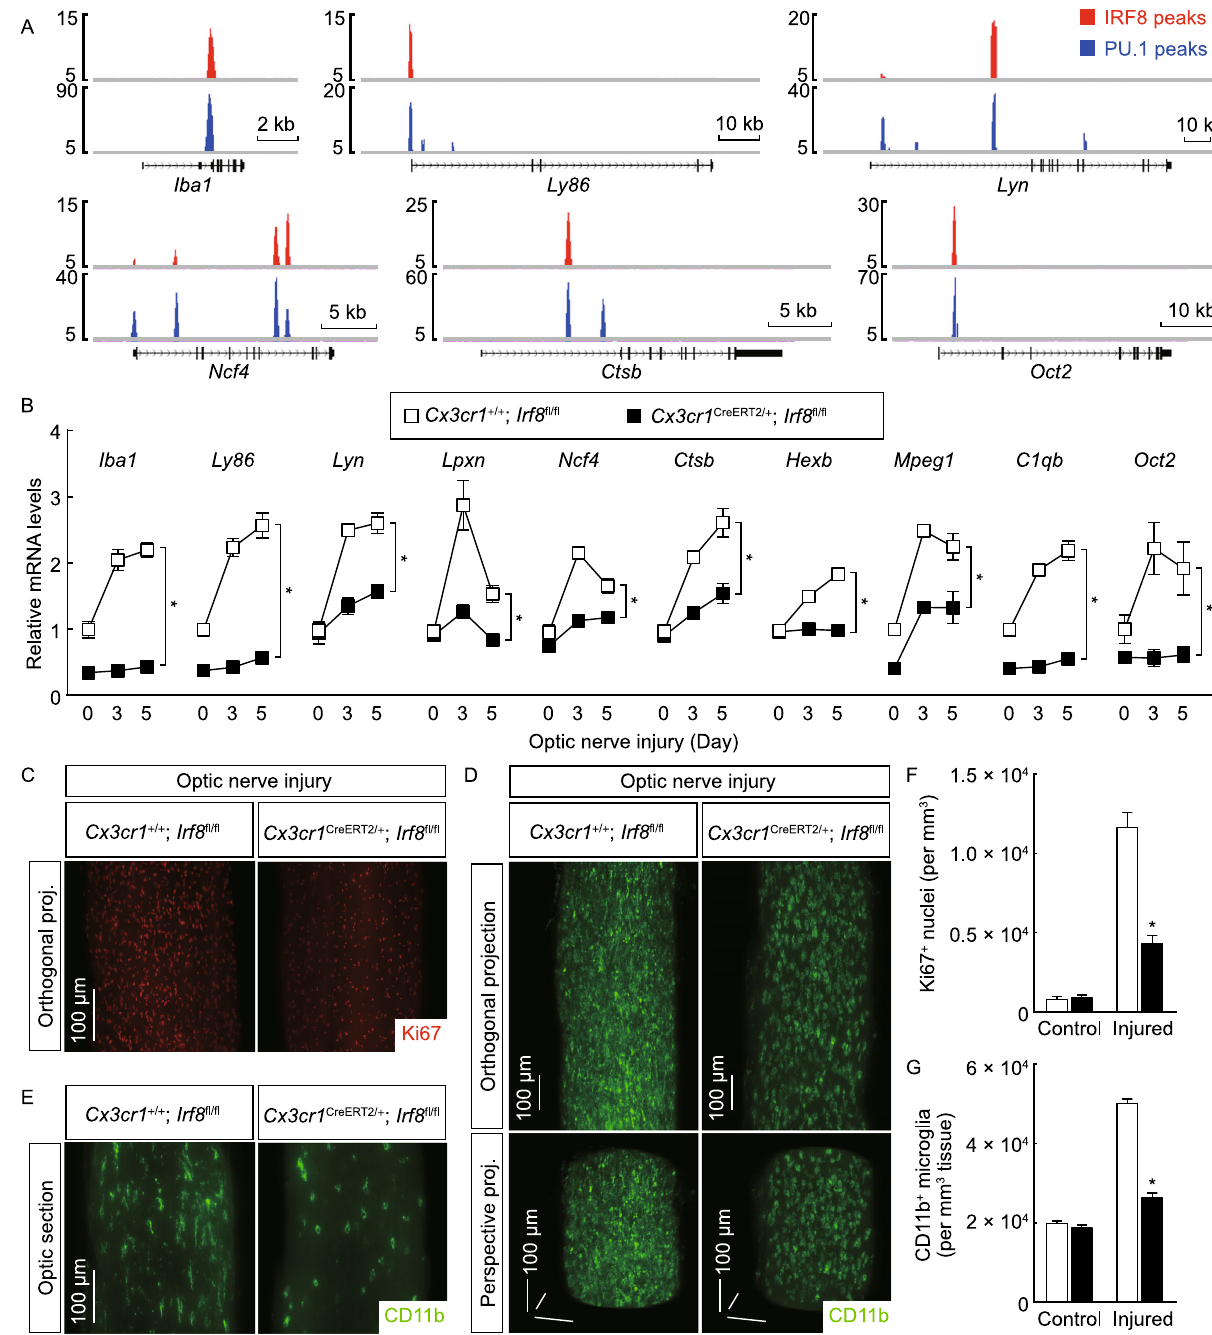
Figure 6. Post-developmental IRF8 is required for microglial activation. (A) IRF8 and PU.1 cooperatively target microglial activation-related genes. IRF8 and PU.1 target sites at the indicated gene loci are shown. (B – G) Post-developmental IRF8 is required for microglial activation. Cx3cr1 +/+ ; Irf8 fl / fl vs. Cx3cr1 CreERT2 /+ ; Irf8 fl / fl mice were treated with 4-hydroxytamoxifen to induce the Cre- recombinase activity and then subjected to optic nerve injury. (B) Expression levels of the indicated genes in the optic nerves were examined by qPCR analysis. n = 4, mean ± SEM, * P < 0.01 (ANOVA test). (C to G) The control and injured nerves were processed for the whole-tissue immunolabeling of Ki67 (C and F) or CD11b (D – G) and imaged on the lightsheet microscope. (C) Representative orthogonal 3D projections of the Ki67-immunolabeled injured nerves. (F) Density of Ki67 + nuclei. n = 3, mean ± SEM, * P < 0.01 (ANOVA test). (D) Representative orthogonal (upper panels) or perspective (lower panels) 3D projections of the CD11b- immunolabeled injured nerves. (E) Representative optical sections of the CD11b-immunolabeled injured nerves. (G) Density of CD11b + microglia. n = 4, mean ± SEM, * P < 0.01 (ANOVA